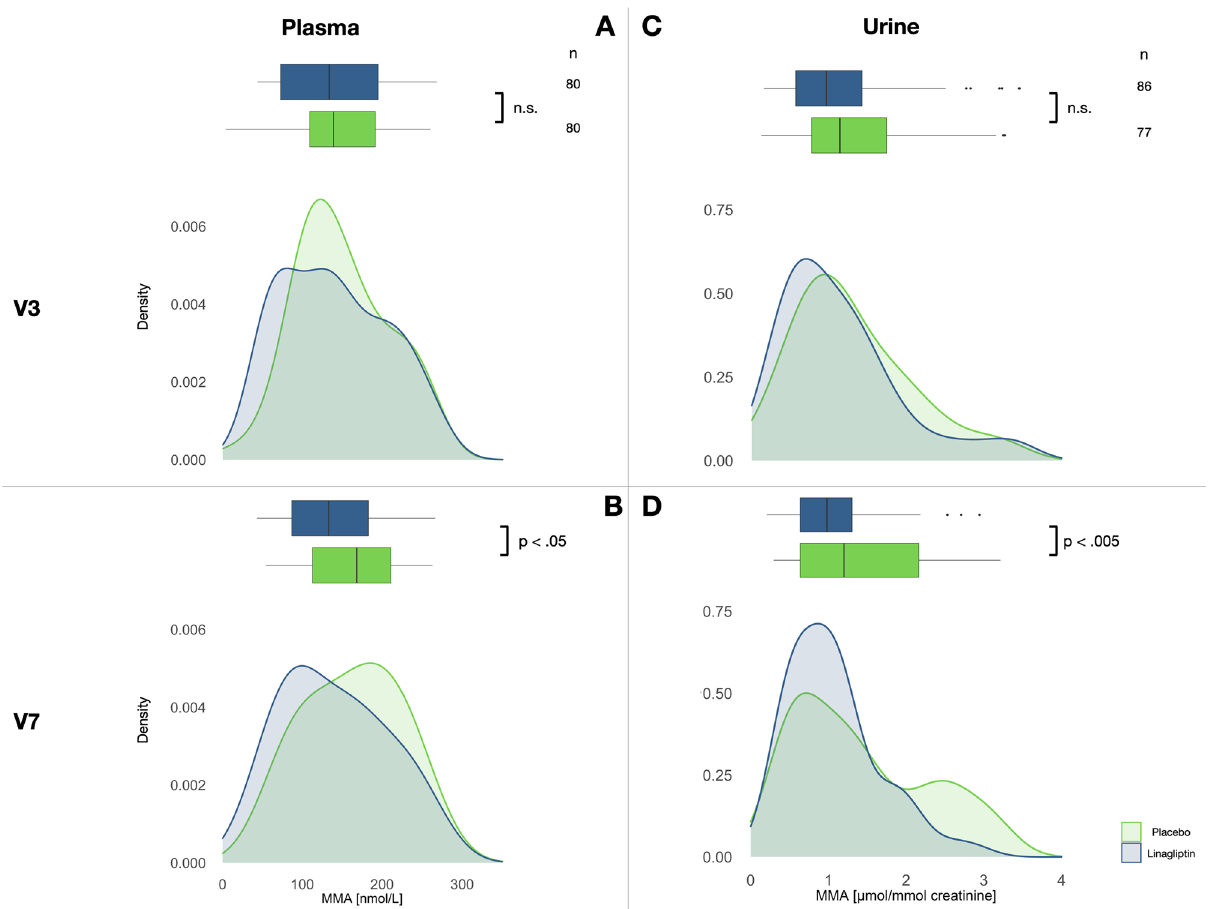
Figure 2. Distribution of MMA values in plasma and urine at V3 and V7 in individuals with medium MMA levels in dependence of treatment. MMA values for plasma (nmol/L, left, A and B) and urine samples (µmol/ mmol creatine, right, C and D) for placebo (green) and linagliptin (blue) at V3 (top, A and C), and V7 (bottom, B and D). The number of samples in each group is shown at the top right. Statistically significant differences between placebo and linagliptin are indicated (Welch t-test). Data is shown as a box-and-whisker plot and the corresponding kernel density estimation. The data shows a shift of MMA values at V7 to the right (towards higher MMA values) in the Placebo group. The shift is also depicted in median and mean values shown in Tables 5 and 6, respectively. MMA, methylmalonic acid; n.s., not significant; V3, baseline; V7, end of